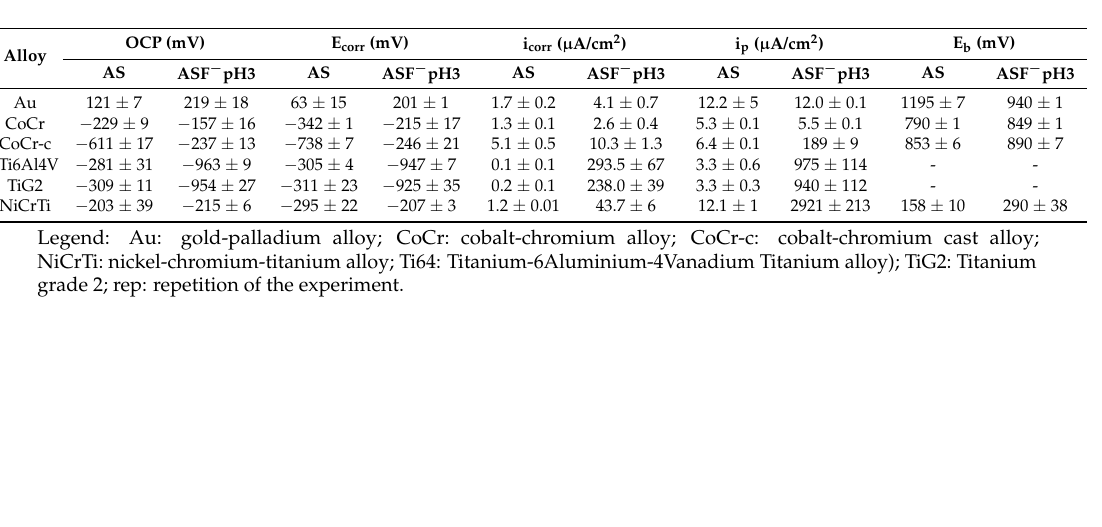
Table 2. Electrochemical parameters of the studied alloys in AS and ASF − pH3.